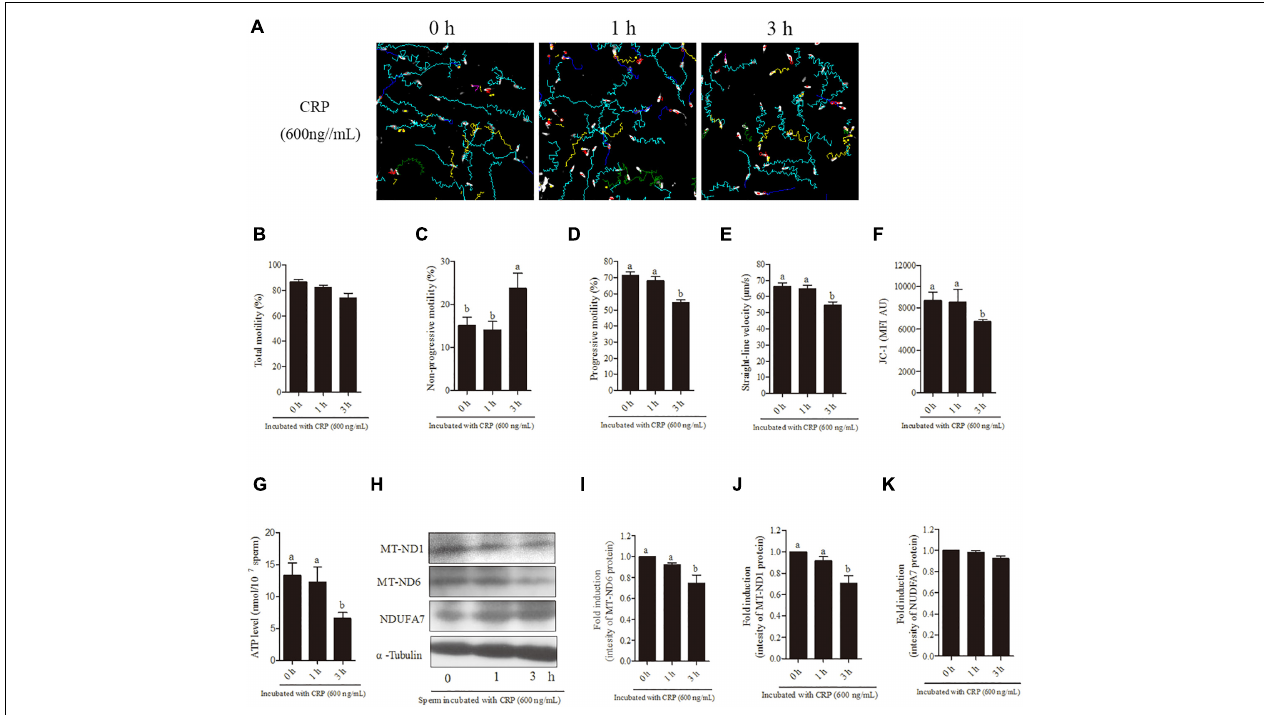
FIGURE 5 | Effect of 600 ng/mL CRP on boar sperm during 3 h incubation in 30.6 mM glucose media. (A) Changes in the motility tracks of sperm generated by CASA system. (B–G) Time-dependent changes in the sperm (B) total motility, (C) non-progressive motility (D) progressive motility, (E) straight-line velocity, (F) mitochondrial activity, and (G) ATP level. (H) Western blotting image showing the expression of the MT-ND1, MT-ND6, NDUFA7, and α -tubulin. (I–K) Quantitative expression of the MT-ND1, MT-ND6, and NDUFA7 over α -tubulin (control) generated from western blotting. Values are means ± SEM of three replicates. Columns with different lowercase letters differ significantly ( p <